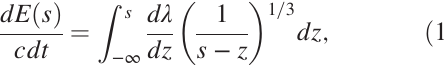
FIG. 15. RMS energy spread induced by the CSR effect as a function of the arc length L of the dipole magnet. Here, dipole Δ σ ¼ σ − σ σ δ δ ; ON δ ; OFF , where δ ; ON is the RMS energy spread with the CSR effect and σ δ is that without the CSR ; OFF ¼ − ρθ , except for the regime in Fig. 15 that Δ σ δ ∝ − L dipole which the length of the dipole magnet is rather short. In